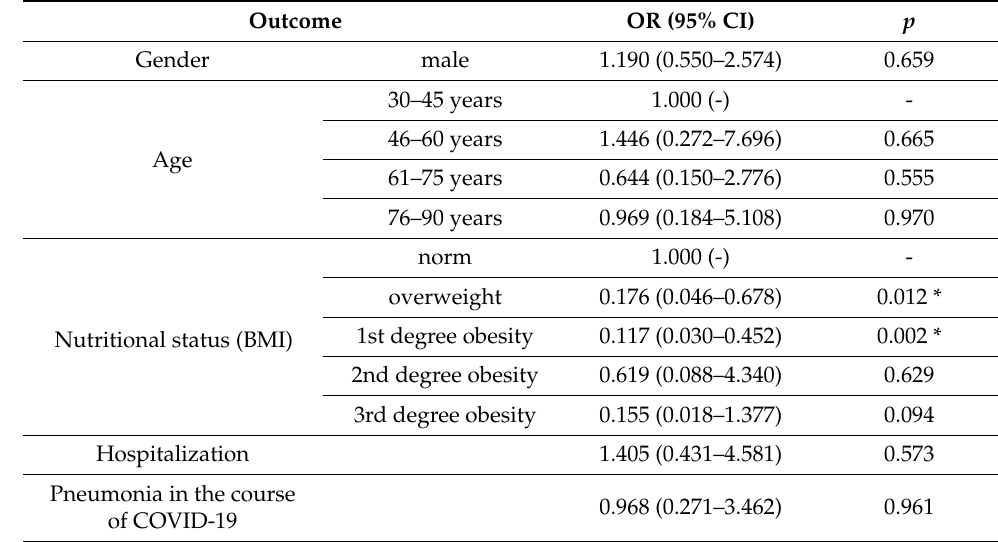
Multivariate logistic regression for predicting lung-function improvement after